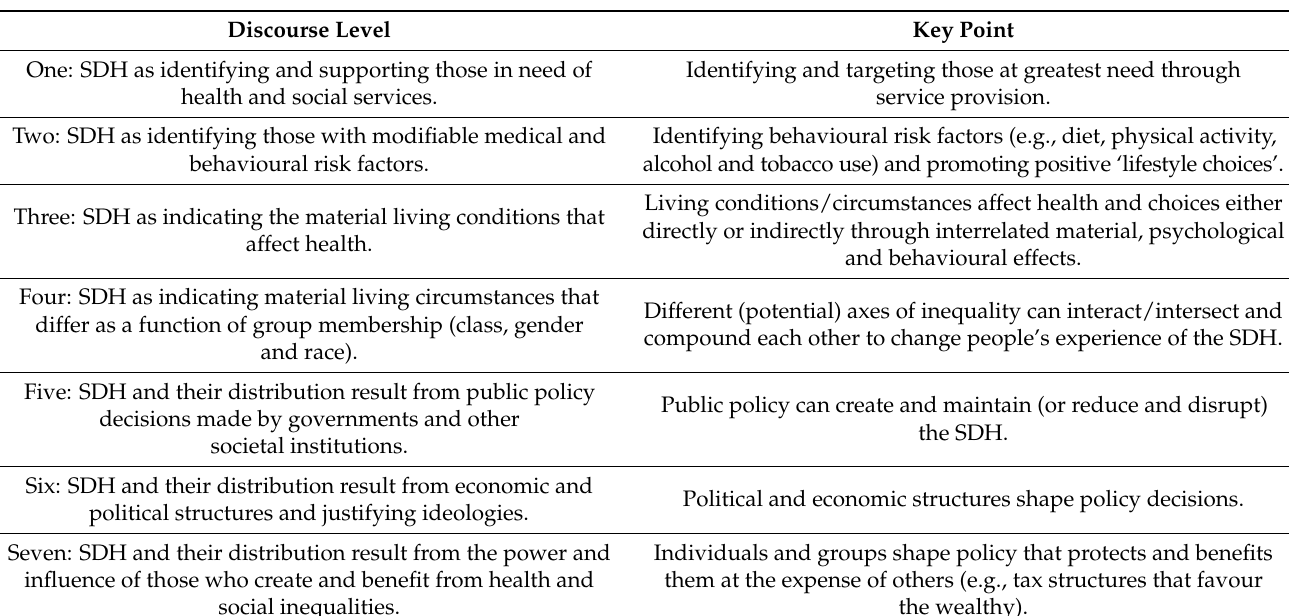
Table 1. Summary of Raphael’s (2011) seven discourses of the social determinants of health (SDH). Discourse